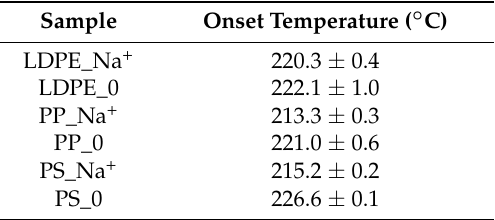
Table 7. Onset temperature of ADC decomposition with the different types of nanoclays in the materials with Na + .